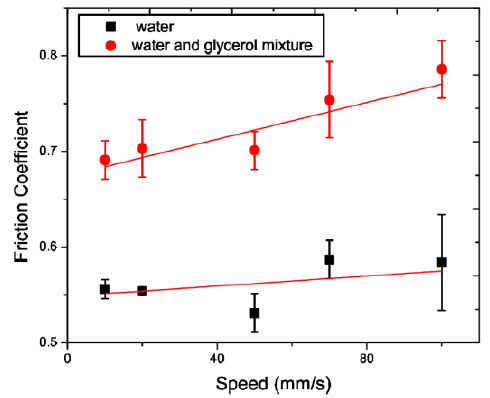
Fig. 3. Dynamic friction coefficient as a function of the velocity of the slider for two types of granular systems: sand + pure water (black solid squares) and sand + a water/glycerol mixture (weight percentage of 0.65; red solid circles). The volume fraction of the interstitial liquid is fixed at 3% for all experiments. Higher impact velocities result in more energy dissipation. The wet granular system with a high-viscosity liquid as the interstitial liquid shows higher friction coefficients and a stronger velocity-dependence.